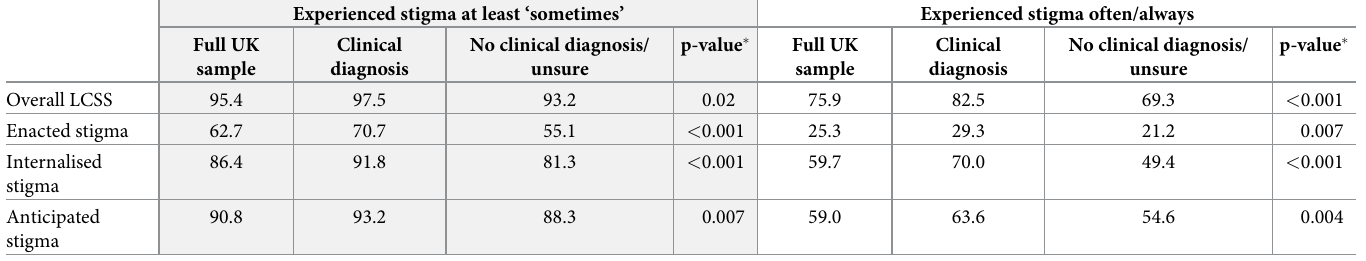
Table 5. Prevalence of stigma in the UK-based